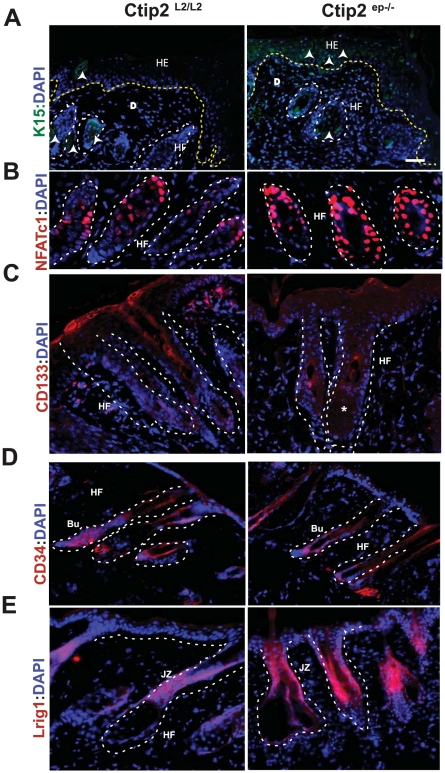
Aberrant expression of markers of HF stem cells in Ctip2ep−/− mice skin during wound repair.IHC analysis of (A) K15, (B) NFATc1 (red), (C) CD133 and (D) CD34 and (E) Lirg1 expression in HF on day 5 post wound healing samples from Ctip2L2/L2 and Ctip2ep−/− mice, using specific antibodies (* indicates loss of CD133 positive cells). The yellow dotted lines indicate the separation of epidermis from dermis near the wound bed (Day5 samples) in (A) and white dotted lines outline the HF. All sections were counterstained with DAPI (blue). Arrow heads indicate K15 positive cells (A). HE-hyperproliferative epithelium; E- epidermis; D- dermis; HF- Hair follicle; Bu-Bulge; JZ-junctional zone. Scale bars: 50 µm.